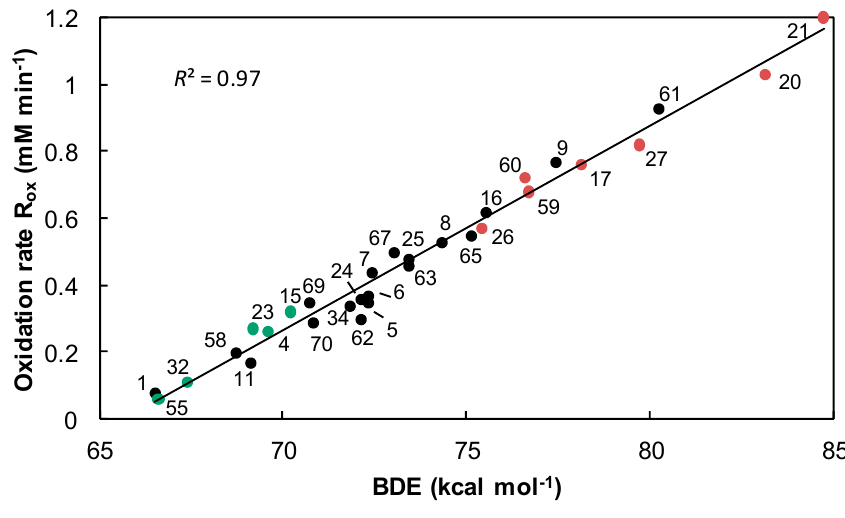
Figure 15. Oxidation rates as a function of the BDEs calculated with the 15. Oxidation rates as a function of the BDEs calculated with B3LYP/6-311++G(2d,2p)//B3LYP/6-311G(d,p) DFT method, stoichiometric numbers are indicated by: